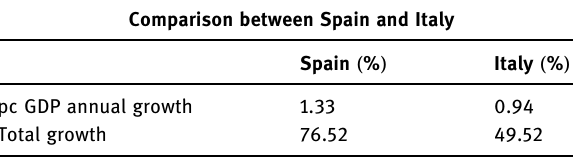
Table 4: Economic growth in Spain and Italy Comparison between Spain and